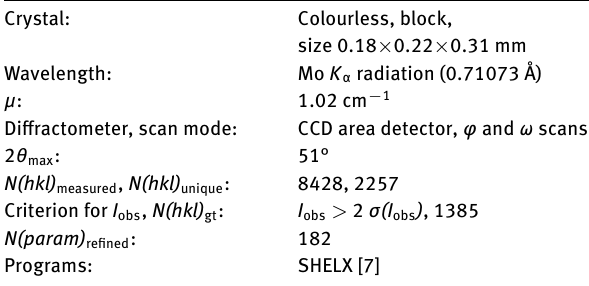
Table 1: Data collection and handling.